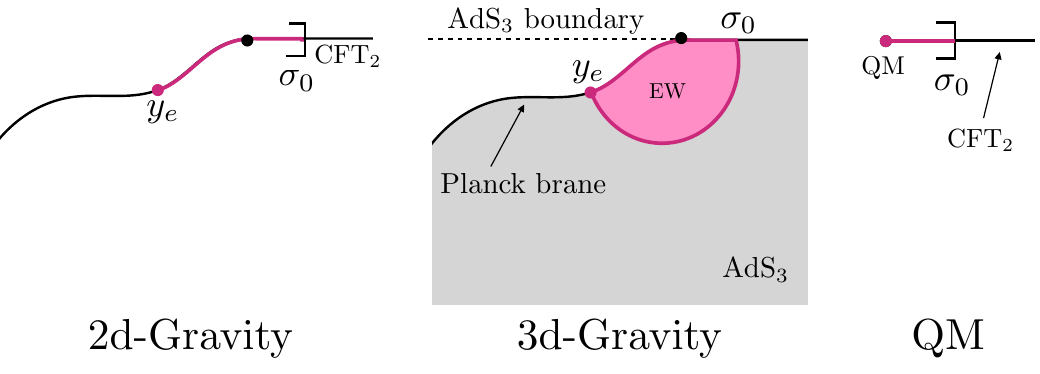
Figure 4 . The entanglement wedge for the black hole at late times. We show a spatial slice (cid:6) at some late time that passes through the quantum extremal surface, (see also (cid:12)gure 5). In the leftmost picture, we have drawn (cid:6) Late in the 2d geometry. The middle picture is a spatial slice of the three dimensional geometry that ends on (cid:6) Late and contains the RT/HRT surface, the pink region being the entanglement wedge. In the rightmost picture, we have an interval that contains the left boundary and whose entropy we are trying to